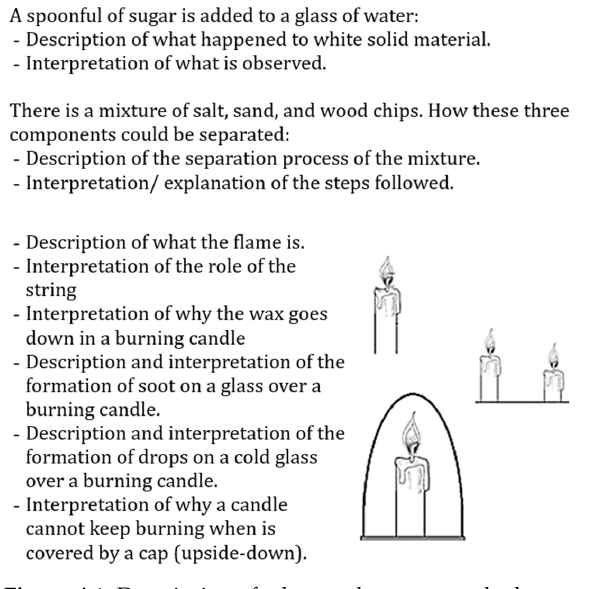
Figure A1. Description of what students were asked to answer in the open-ended items.